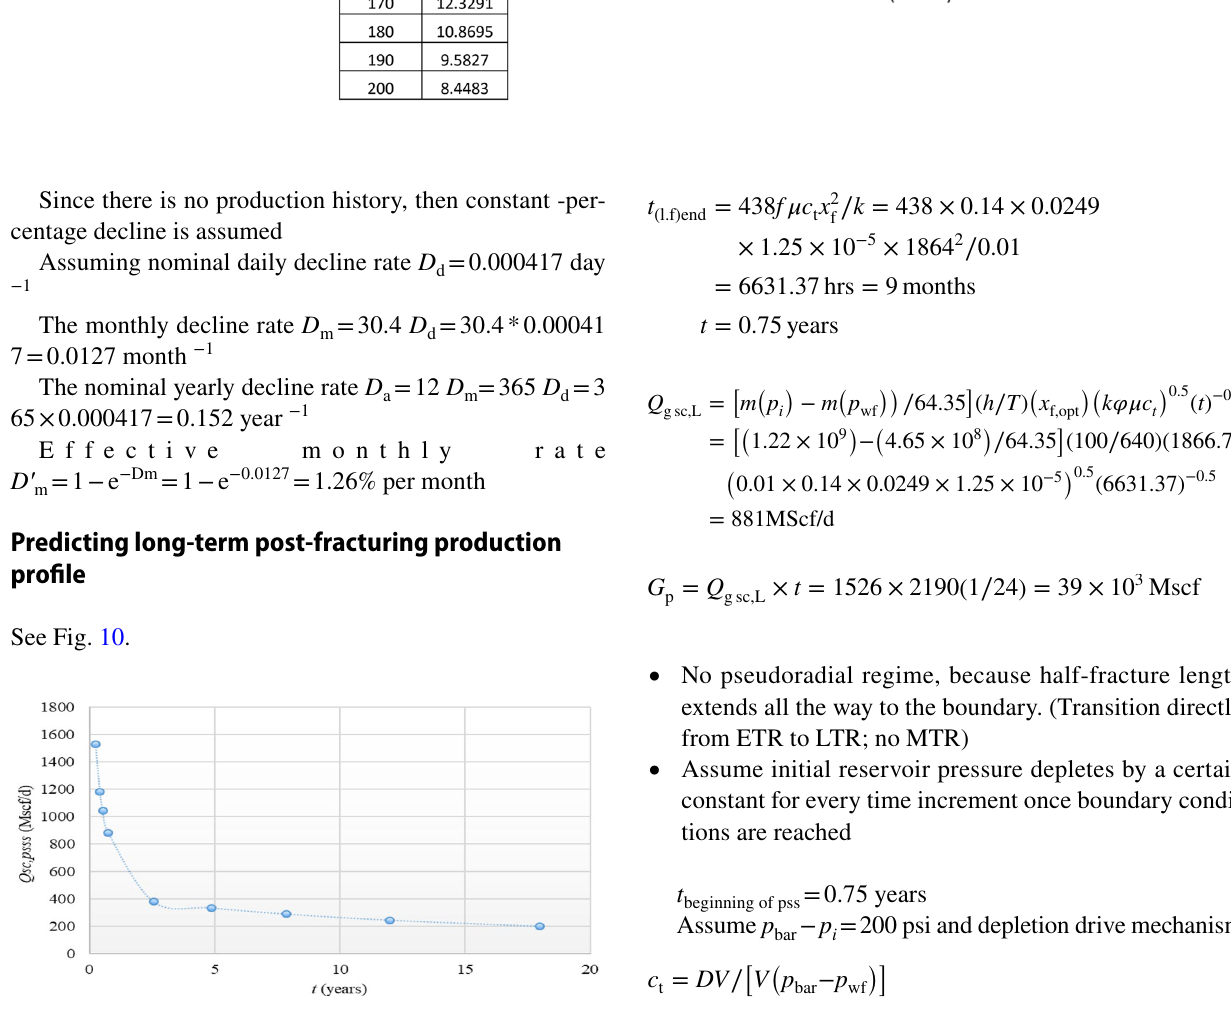
Fig. 10 Long term post-fracturing production